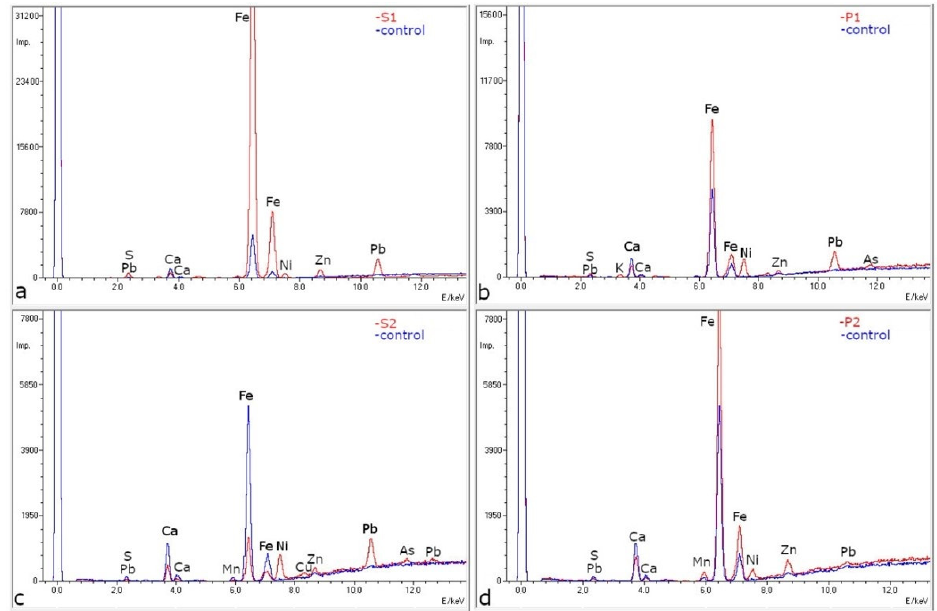
Figure 5. Selected ED-XRF spectra of archaeological wood samples S1 ( a ), P1 ( b ), S2 ( c ) and P2 ( d ) and reference wood samples (control) for P1 and P2 pine reference wood and for S1 and S2 spruce reference wood.